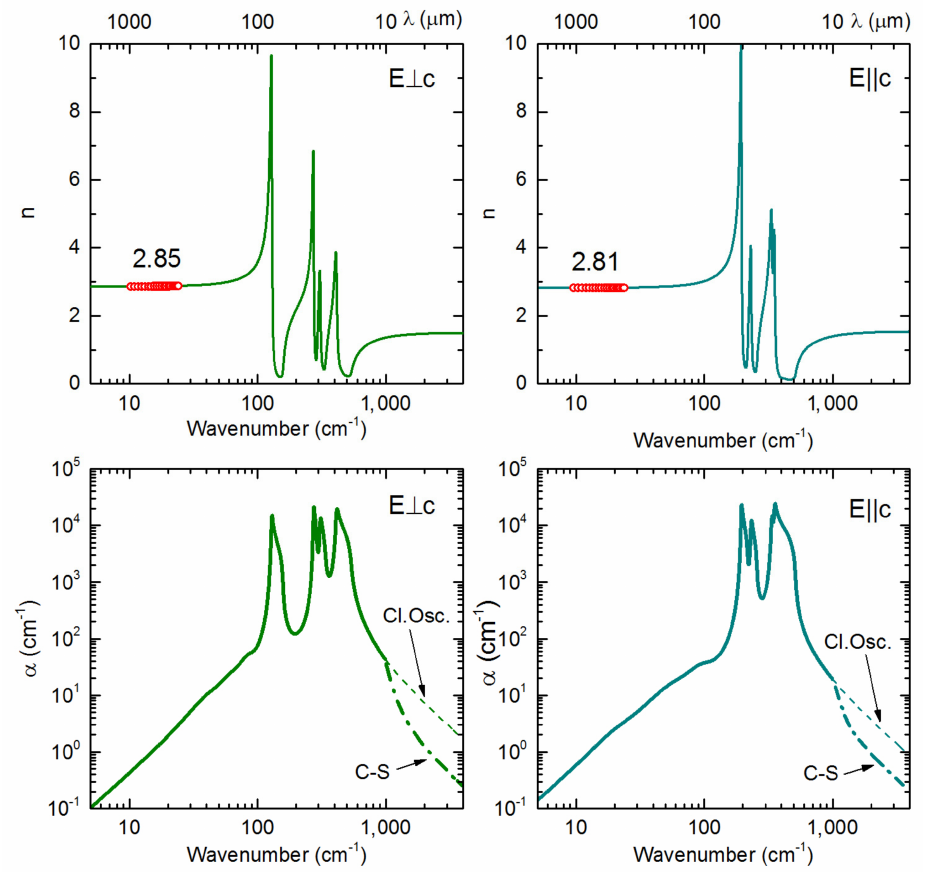
Figure 7. Calculated spectra of the refractive index and absorption coefficient of the LiGdF 4 single crystal in the THz-IR ranges at room temperature. Solid lines are the spectra n( ν ) and α ( ν ) calculated using parameters given in Tables 1 and 2, and hollow circles are refractive index values obtained directly from interference pattern using model